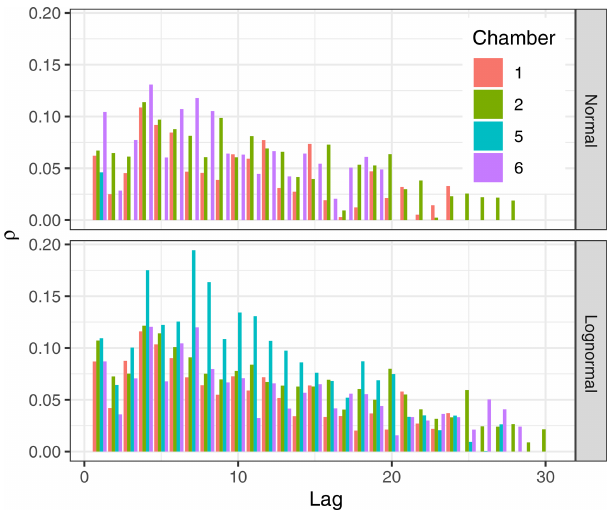
Figure C1. Empirical correlation coefficients are stronger between residuals on a log-transformed scale (bottom).